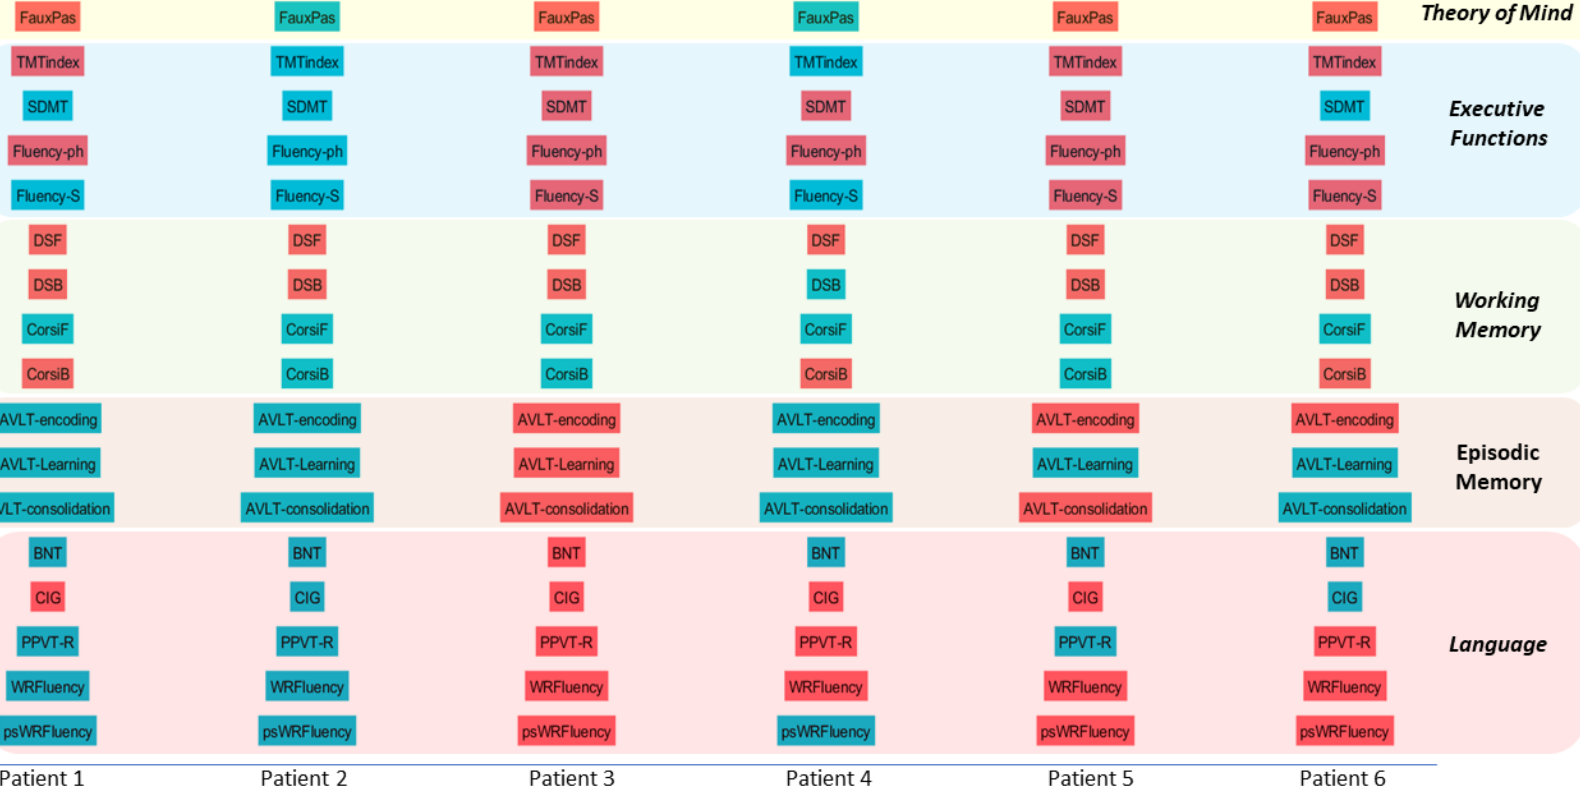
Figure 2. Neurocognitive profiles of the six patients with full neuropsychological data. Red indicates deficit. FauxPas: Faux Pas Recognition Test; ΤΜΤindex: